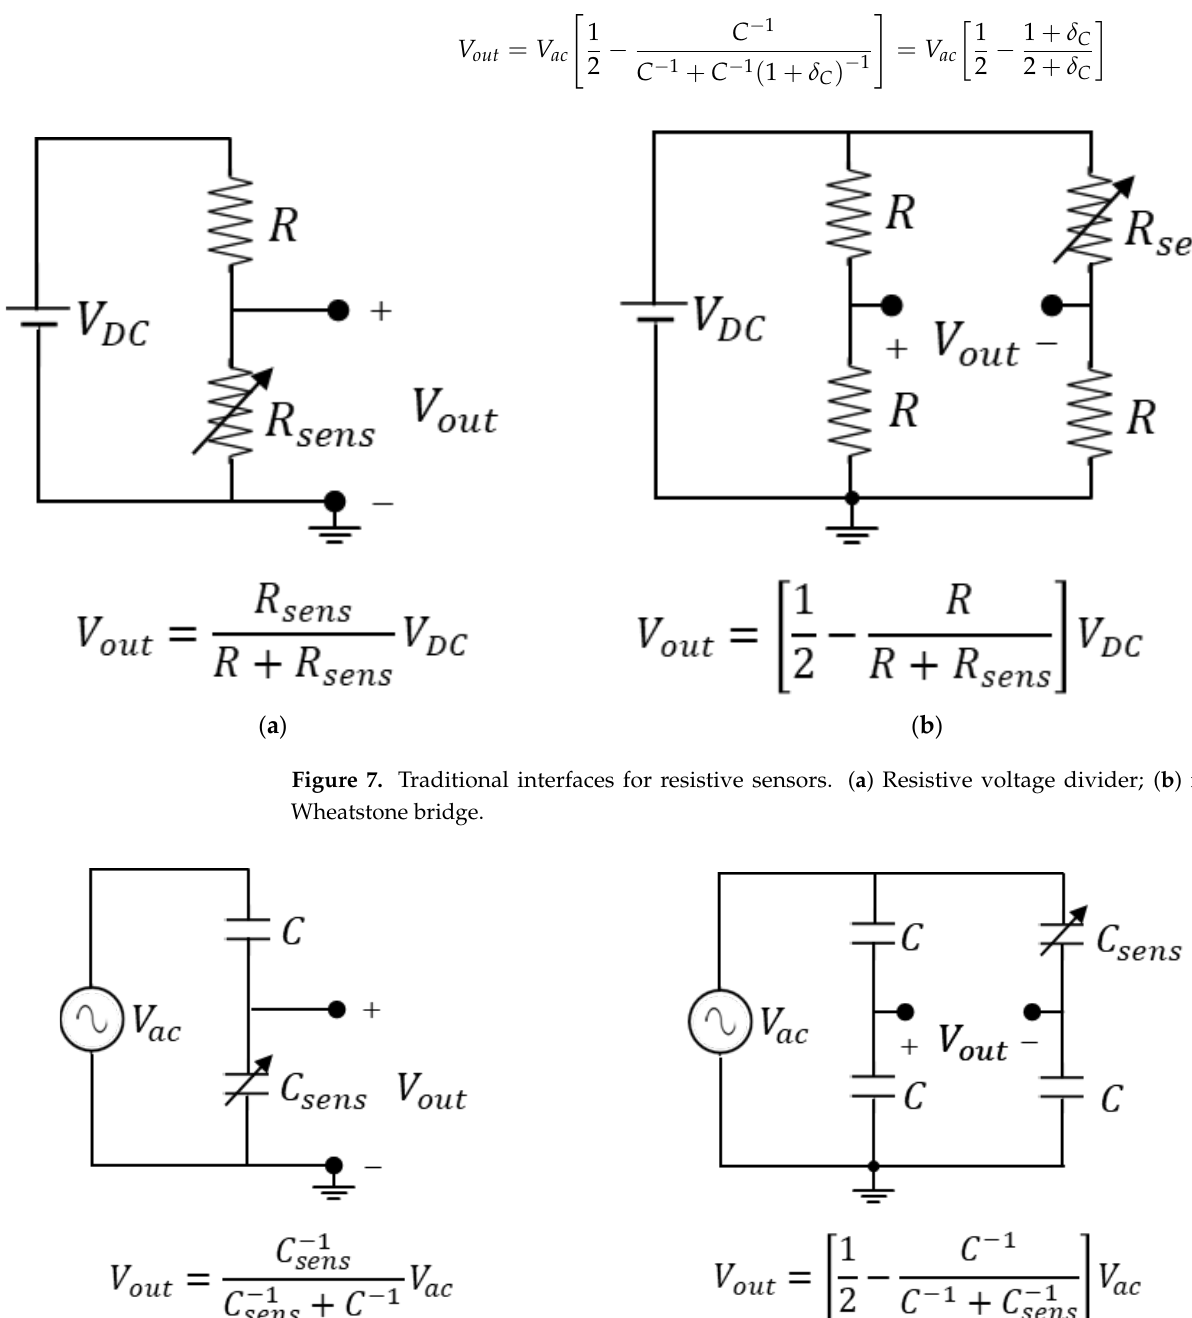
Figure 8. Traditional interfaces for capacitive sensors. ( a ) Capacitive voltage divider; ( b ) capacitive Wheatstone bridge. Here, 𝑉 𝑎𝑐 and 𝑉 𝑜𝑢𝑡 denote AC amplitude values.